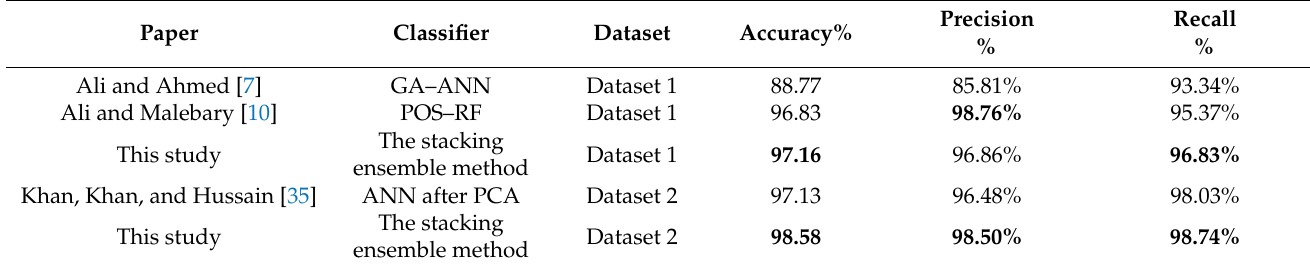
Table 15. Comparison of the proposed method with the previous